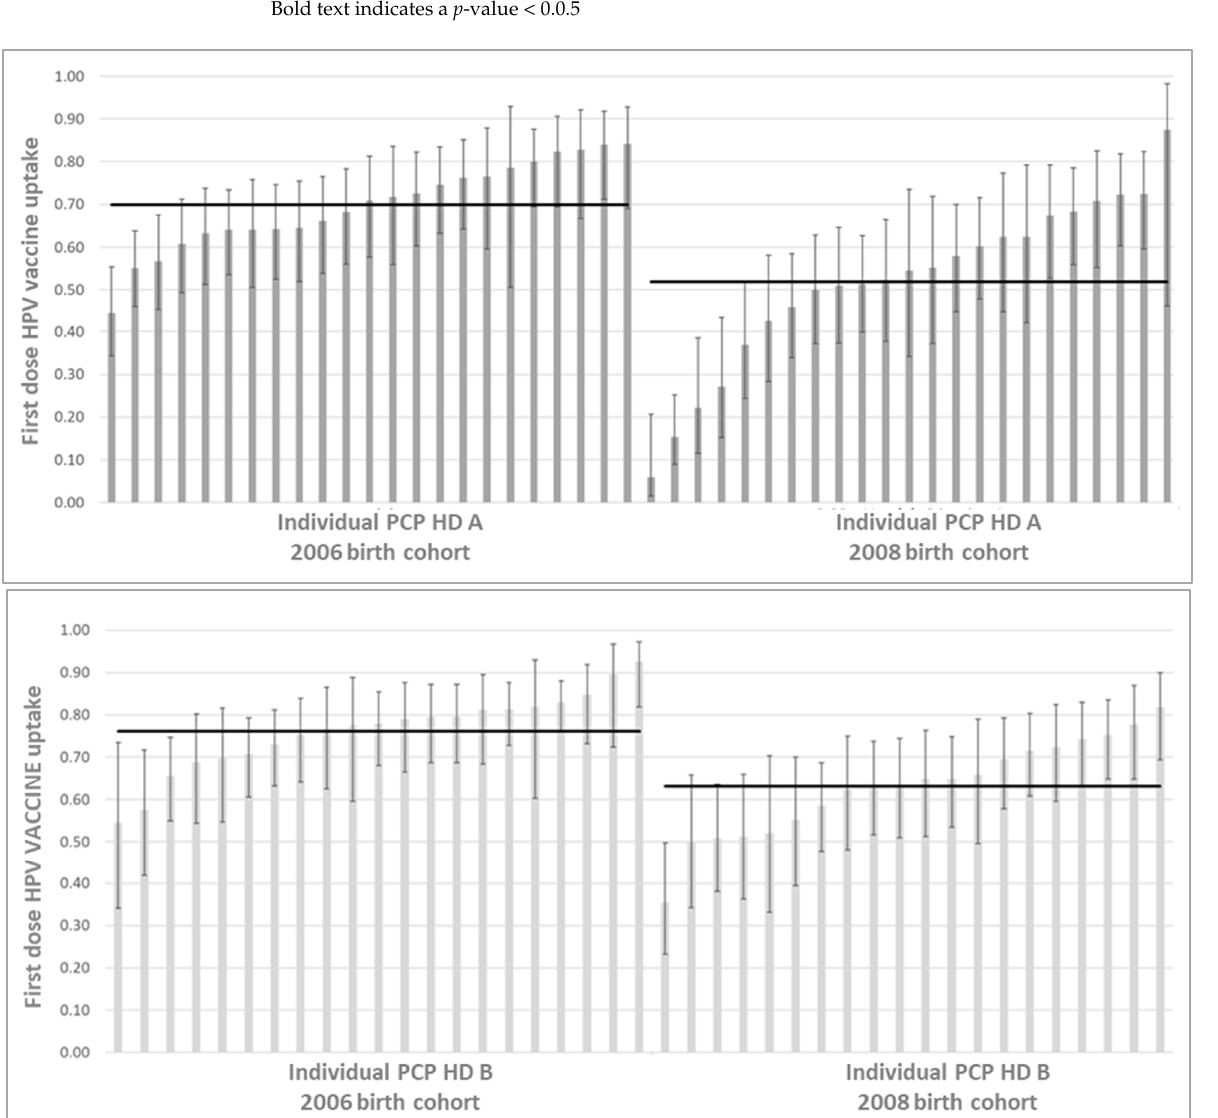
599 64% 1281 58% 0.82 0.76 0.88 Bold text indicates a p -value < 0.0.5